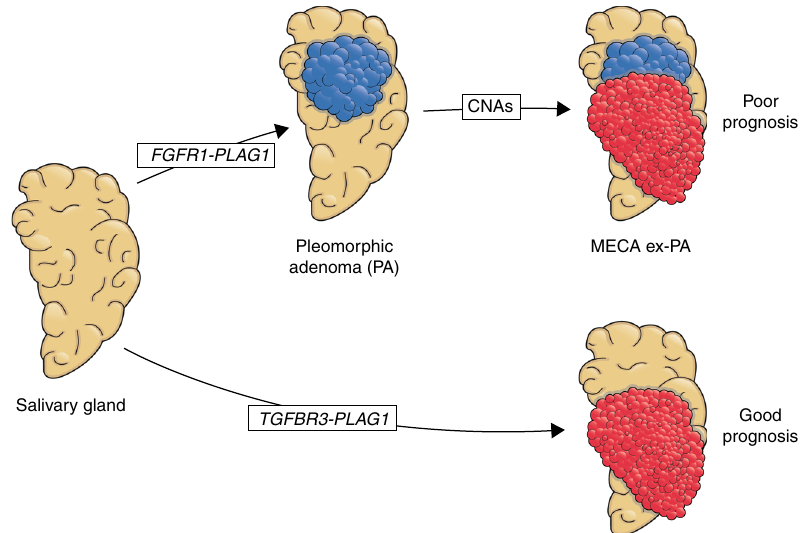
Fig. 7 The role of FGFR1-PLAG1 and TGFBR3-PLAG1 in MECA